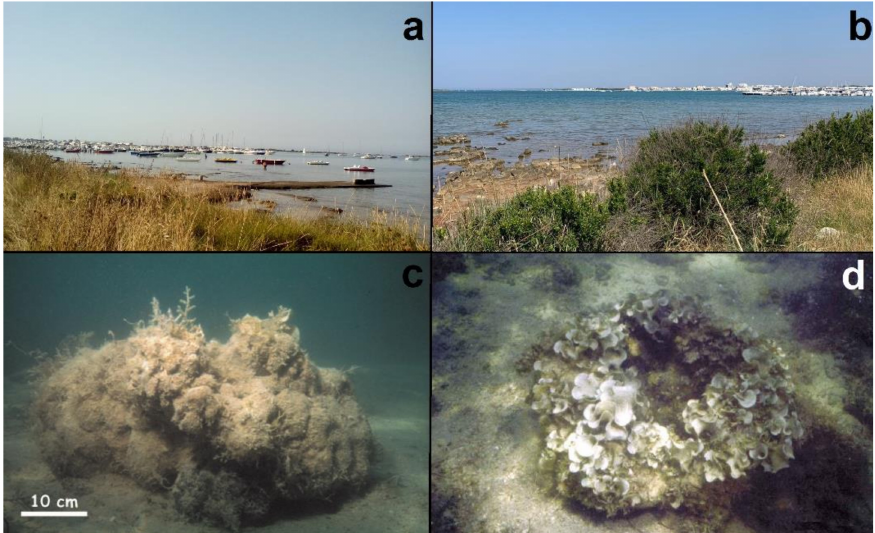
Figure 4. La Strea Bay at the Ionian Apulian coast, Lecce (Italy) showing the dock for the recreational boat mooring ( a , b ), photo credit: M.F. Gravina; massive Geodia cydonium subspherical specimen ( c ); Geodia cydonium specimen covered by epibionts, which protect this sciaphilous sponge from high solar radiation ( d ). Photo by courtesy of G. Corriero, University of Bari,